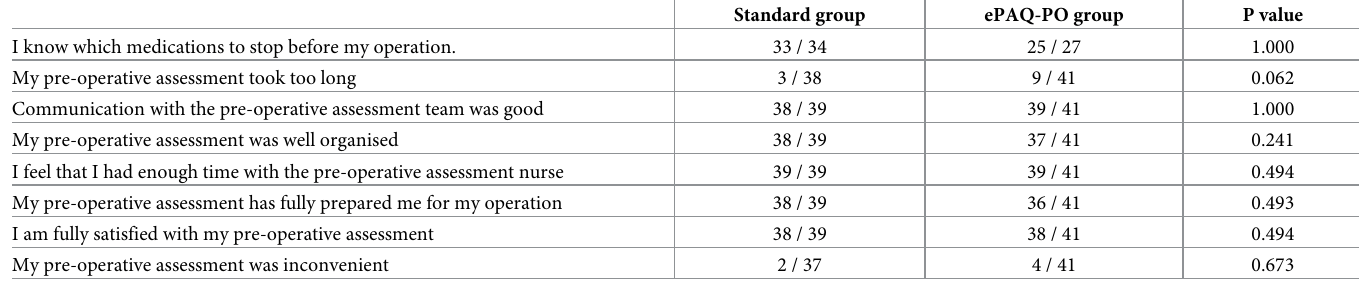
Table 2. Grouped satisfaction data for patients undergoing nurse-led pre-operative assessment with face-to-face consultation (standard group) or with the addition of an electronic questionnaire (ePAQ-PO group). Values shown are the number of patients who agreed or strongly agreed with the statements / total number of patients in each group who answered the question.